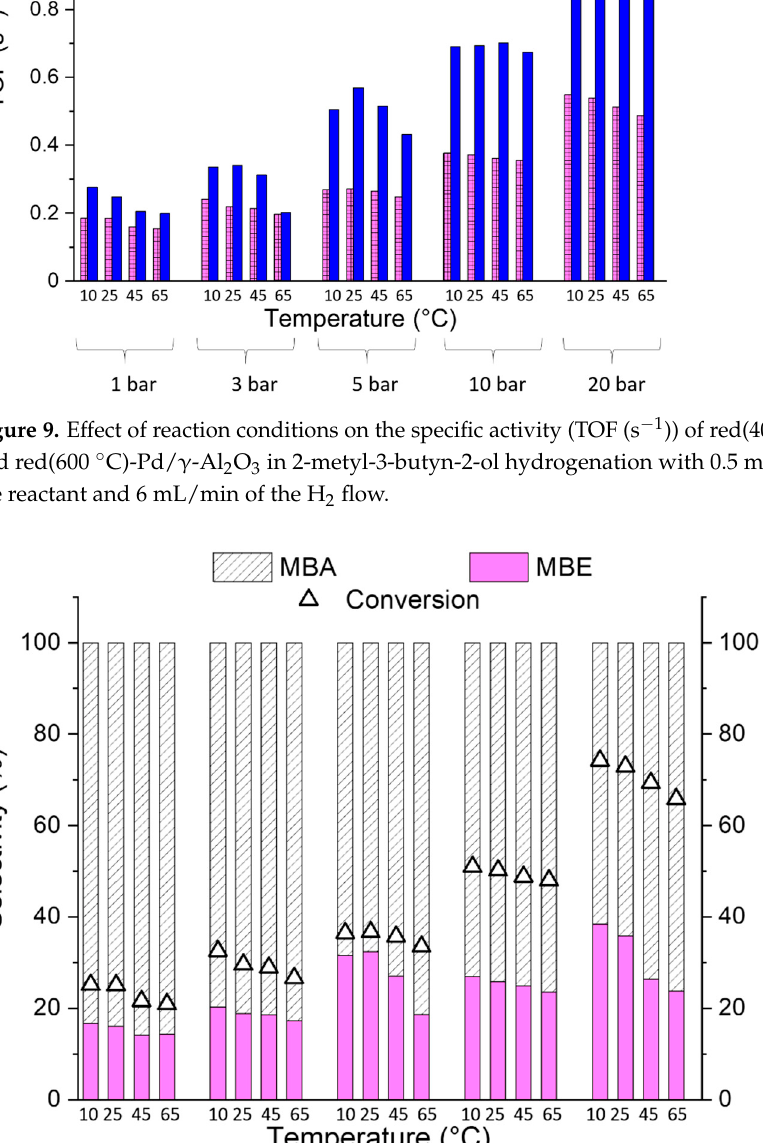
Figure 11. The effect of reaction conditions on the conversion and selectivity of red(600 °C)-Pd/ γ - Al 2 O 3 to 2-methyl-3-buten-2-ol and 2-methyl-2-butanol in 2-metyl-3-butyn-2-ol hydrogenation with 0.5 mL/min flow rate of the reactant and 6 mL/min of the H 2 flow.